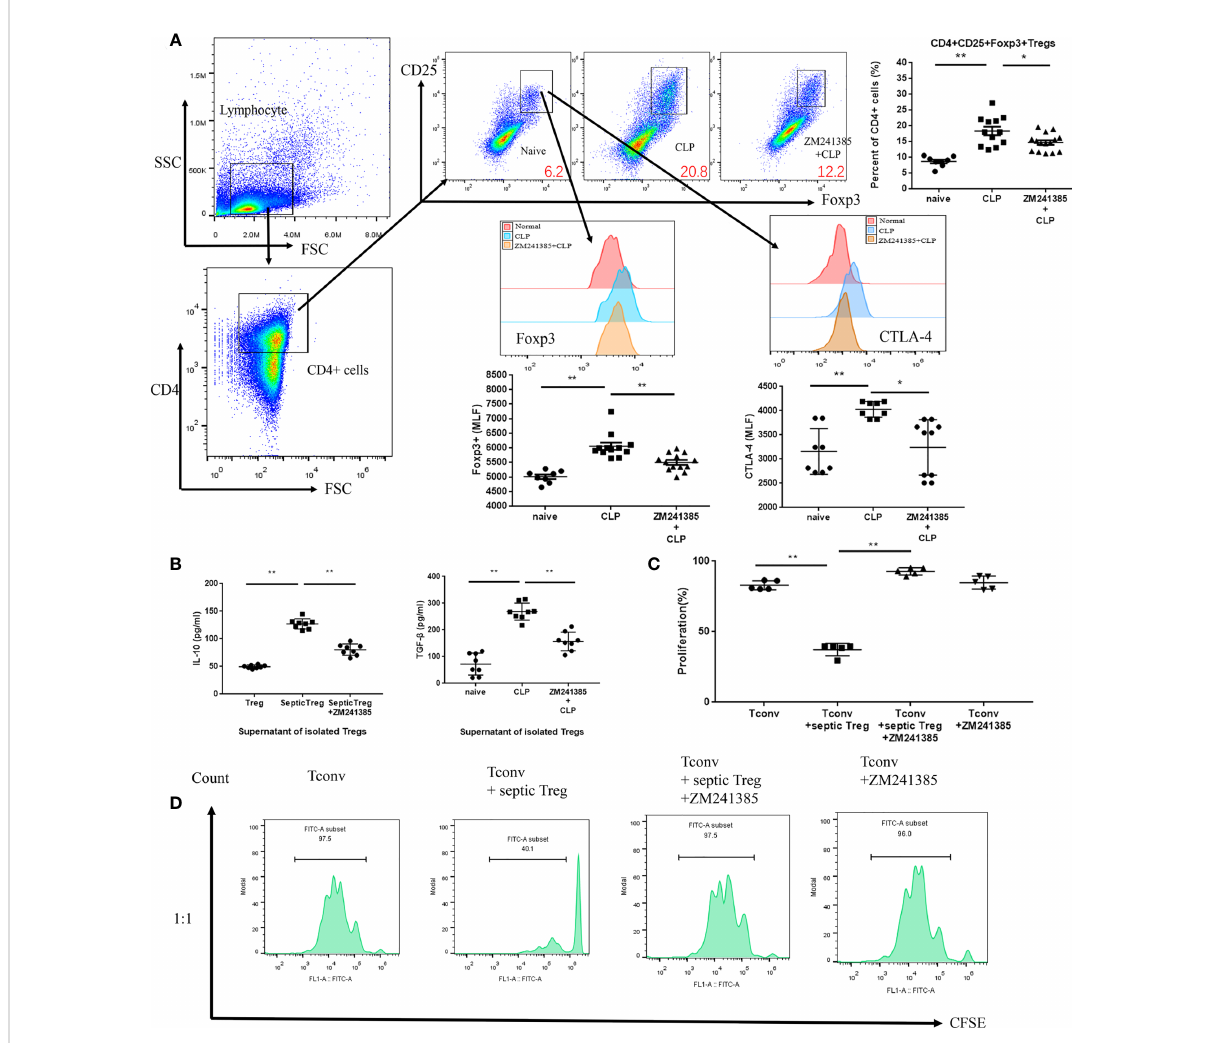
FIGURE 3 A2aR blockade treatment modulates the frequency and function of Tregs in CLP mice. Tregs were collected for testing from the spleens of normal, CLP and ZM241385-treated CLP mice. Tregs were identi fi ed by CD4+CD25+Foxp3+ to elevate percentages of CD4+ cells. (A) Percentages of Tregs from ZM241385-treated CLP mice were decreased compared to those from the CLP group. Expression levels of Foxp3 and CTLA-4 in Tregs were measured by fl ow cytometry. Representative histograms and the mean fl uorescence intensity (MFI) of Foxp3 and CTLA-4 expression are represented. (B) Tregs from the CLP group secreted more cytokines than those from the ZM241385-treated group and naïve group. (C, D) Treg suppression of T-cell proliferation might be reduced if the A2aR was blocked. The individual mice are represented by symbols. * p < 0.05, ** p <